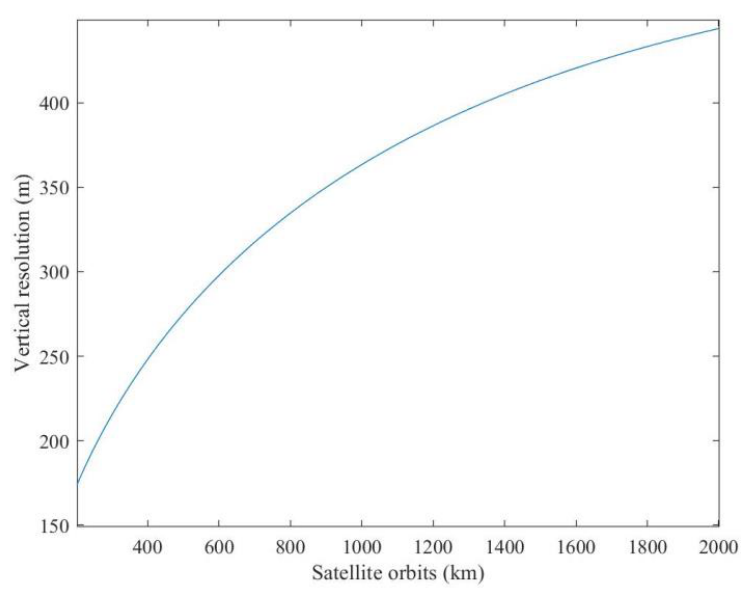
Figure 3. Vertical resolution with the satellite orbits.